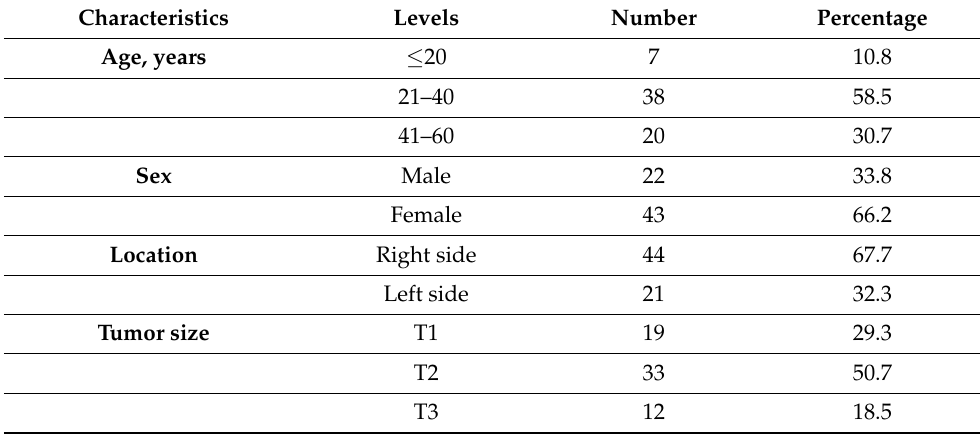
Table 1. Clinicopathological characteristics of renal cell carcinoma patients ( n =